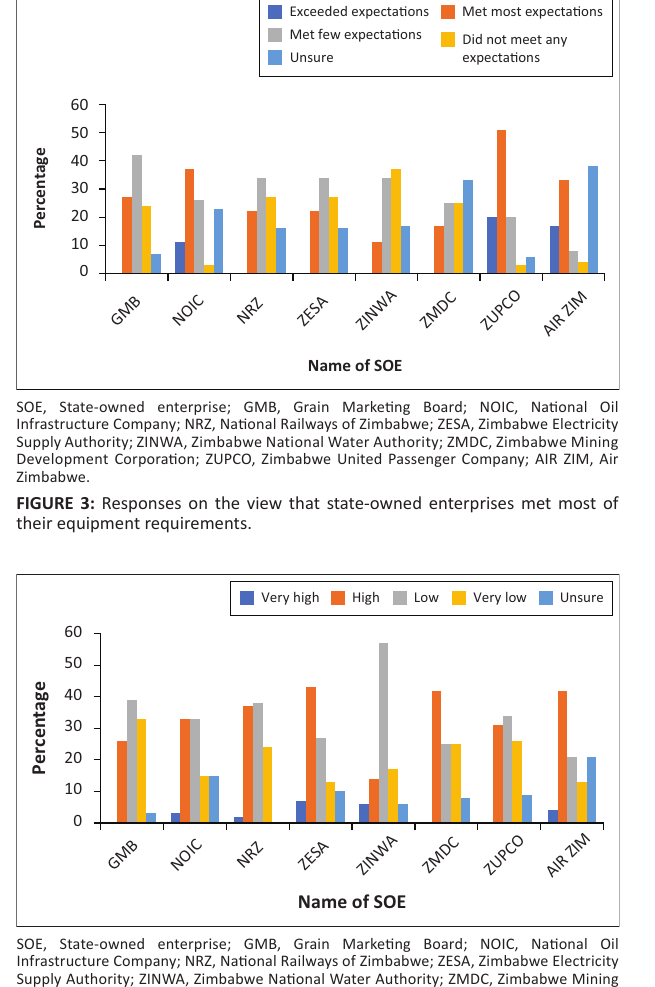
FIGURE 4: Responses on individual innovation in the state-owned enterprises.